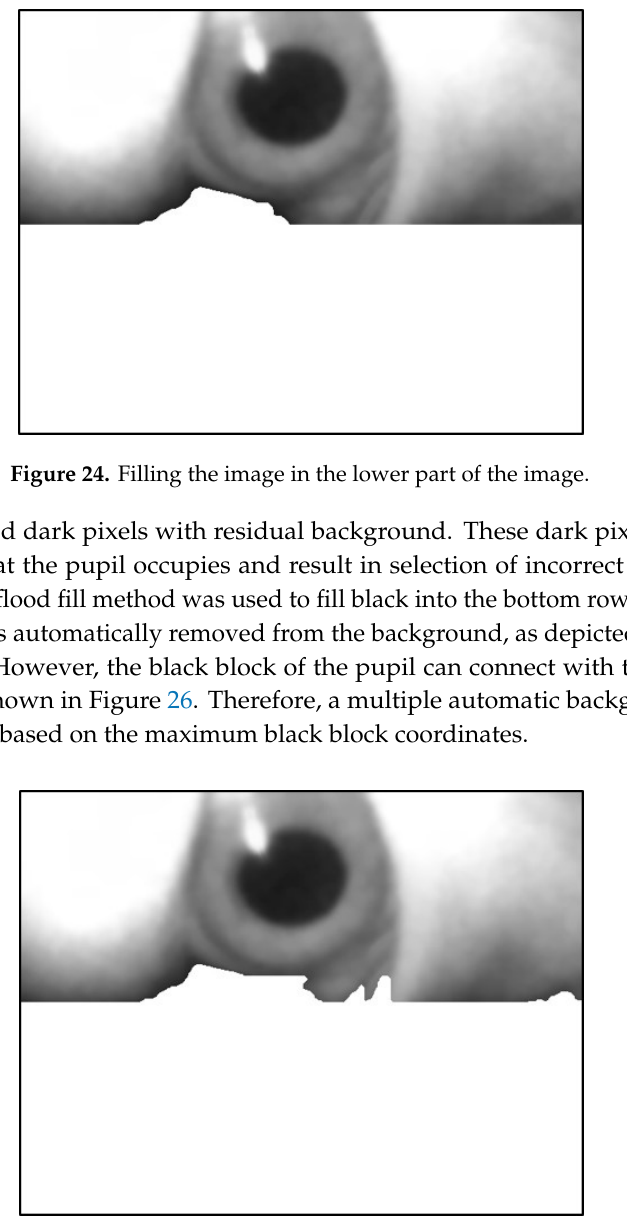
Figure 25. Automatically removed from the background the second time.